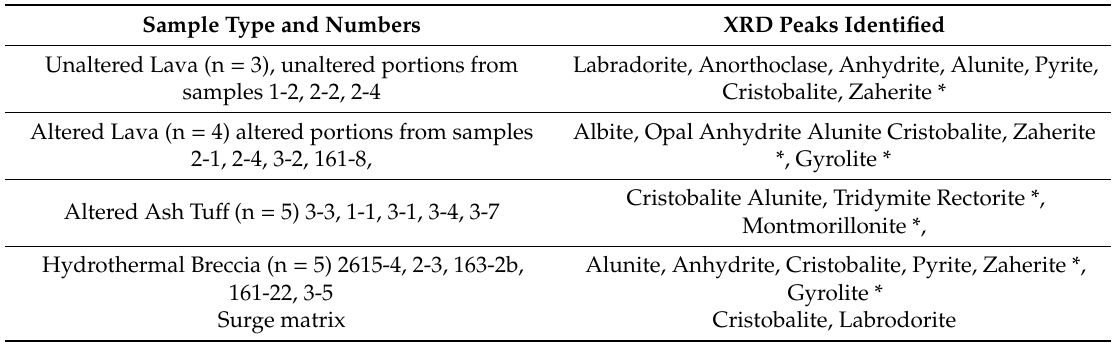
Table 1. X-ray di ff raction data for the samples